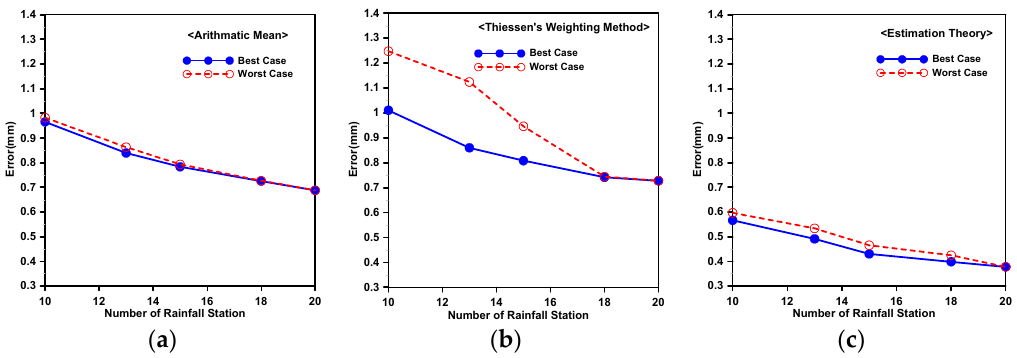
Figure 7. Estimation Error Analysis According to the Change of the Number of Rain Gauge Stations. ( a ) Arithmetic Mean; ( b ) Thiessen’s Weighting Method; ( c ) Estimation Theory. Table 10. Basic statistics of Thiessen Weighting Factors for AAR Estimation.